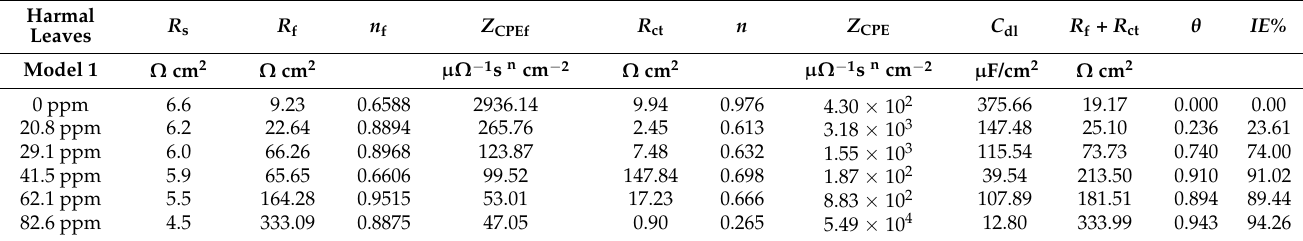
Table 3. Impedance parameters for the Harmal leaf extract on the C-steel in 0.25 M H 2 SO 4 medium by fitting the equivalent circuit model 1.